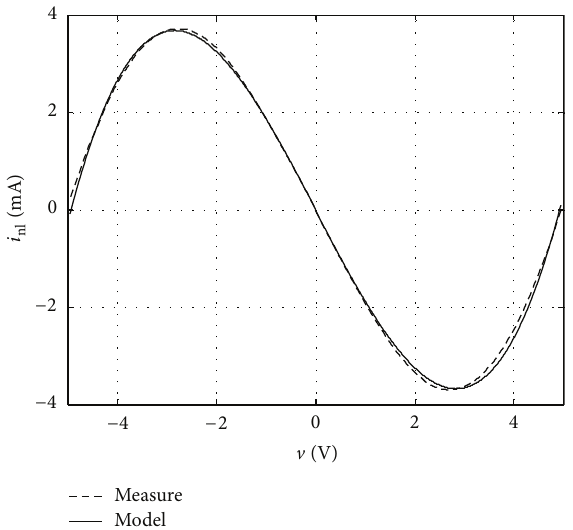
Figure 5: Nonlinear characteristic of the locally active two-terminal = 5 V. Measurements are sub-circuit, shown in Figure 3(a) with 𝑉 DD obtained using integrated circuits ST HCF4007UB and the testing circuit in Figure 4. Approximate model is obtained using a cubic = −1.94 mA/V and 𝑐 = 80 uA/V 3 polynomial with 𝑎 nl nl